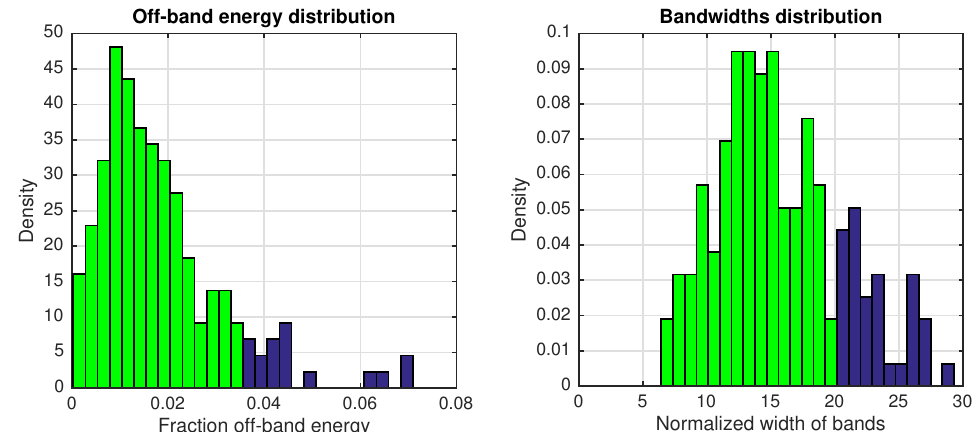
Figure 15. Histograms for relative off-band energy and widths of the